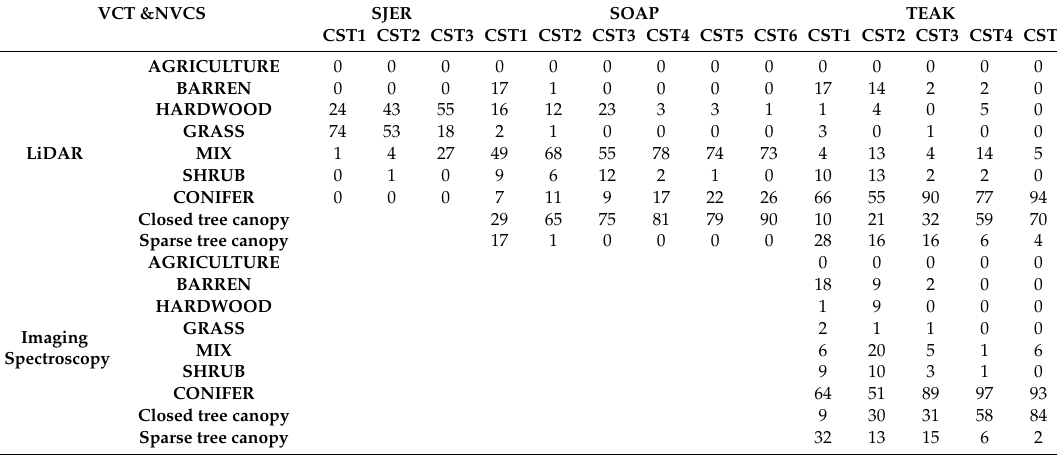
Table 5. Percentage of the vegetation cover types (VCT) and the national vegetation classification standards (NVCS) (i.e., closed and sparse tree canopy attributes) defined within CALVEG mapping for each canopy structural type (CST). SJER and SOAP IS classification were not included as they show minimal di ff erence from LiDAR data. TEAK IS classes are provided as they di ff er the most from LiDAR values, as explained in the